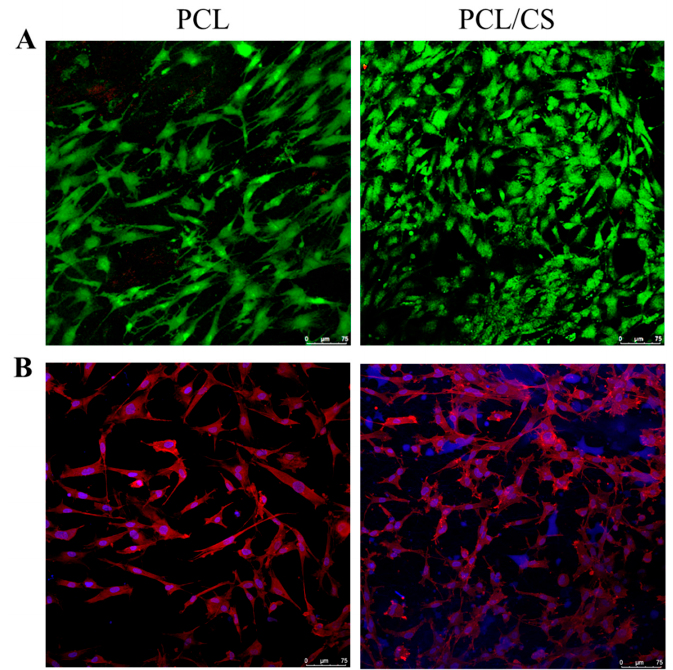
Figure 6. The confocal microscopy observation of mesothelial cells cultured in PCL and PCL/CS nanofiber membranes by live/dead ( A , bar = 75 µm) and nucleus/cytoskeleton staining ( B , bar = 75 µm). The live cells were stained green by calcein AM, and dead cells were stained red by ethidium homodimer-1 in ( A ). The actin cytoskeleton was stained red by phalloidin-rhodamine, and the cell nucleus was stained blue by Hoechst 33258 in ( B ).